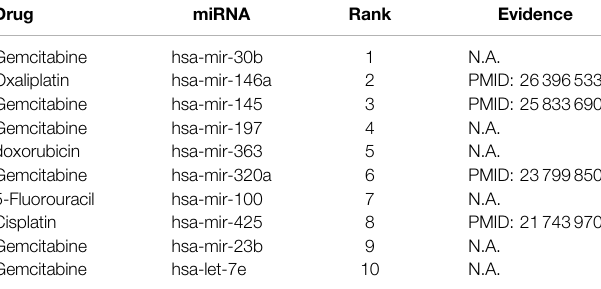
TABLE 4 | Top 10 miRNA-drug resistance associations predicted by AMMGC. Drug Rank